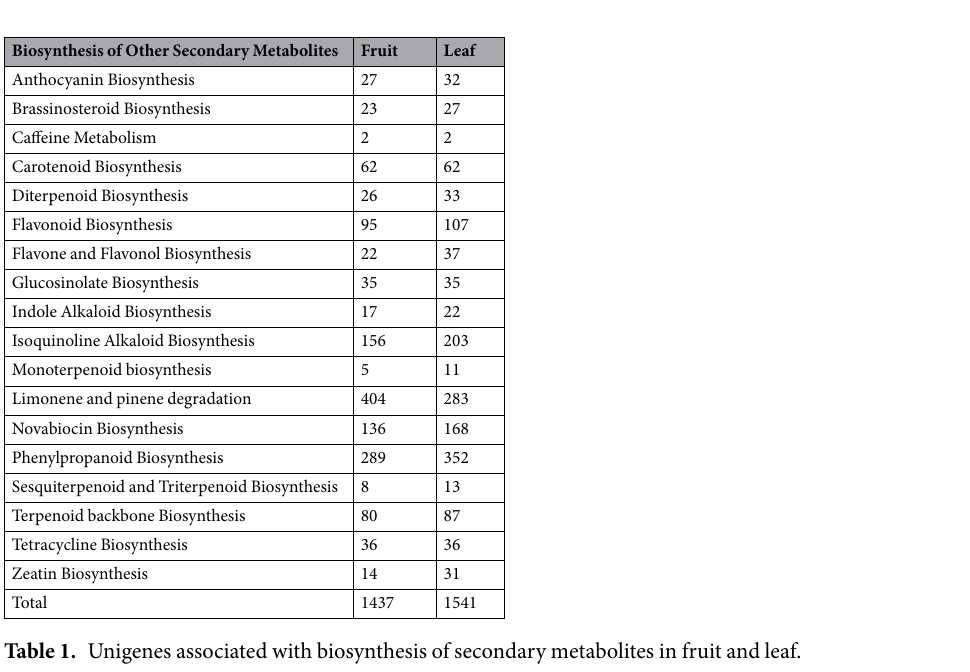
Figure 2. Histogram representing gene ontology classification. Unigenes have been grouped under three main categories: biological process, cellular component and molecular function. Black and white bars represent the percent number of assignments of unigenes present in leaf and fruit respectively. BLAST matches in the TAIR10 database was carried out for each GO term.